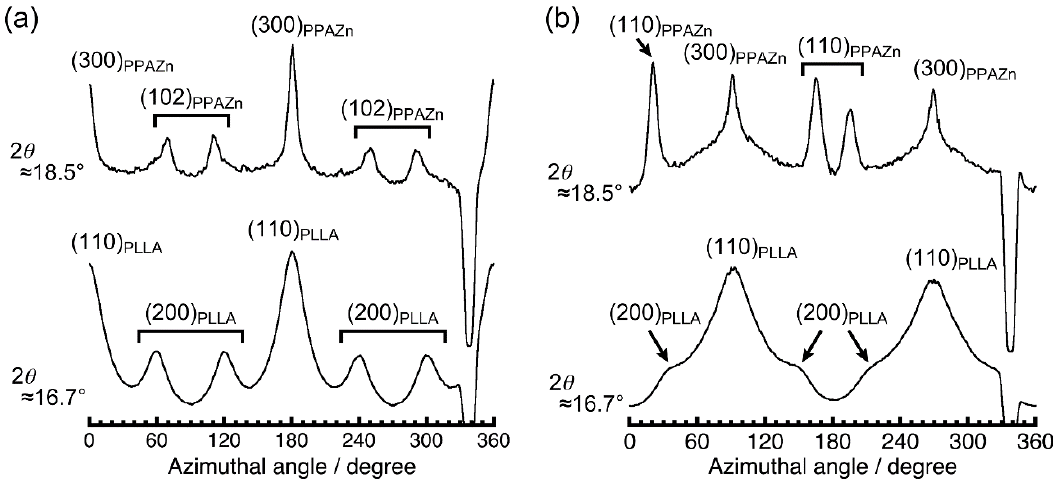
Figure 8. Azimuthal β -scans of ( a ) PPAZn/PLLA-8TS with the 0–180° direction parallel to the direction of the magnetic field ( χ 1 direction of PPAZn), and ( b ) PPAZn/PLLA-8TR with the 0–180° direction parallel to the direction of the sample rotation axis ( χ 3 direction of PPAZn). The β -scans were performed at 2 θ ≈ 18.5° and 16.7° for each 2D pattern in Figure 7.